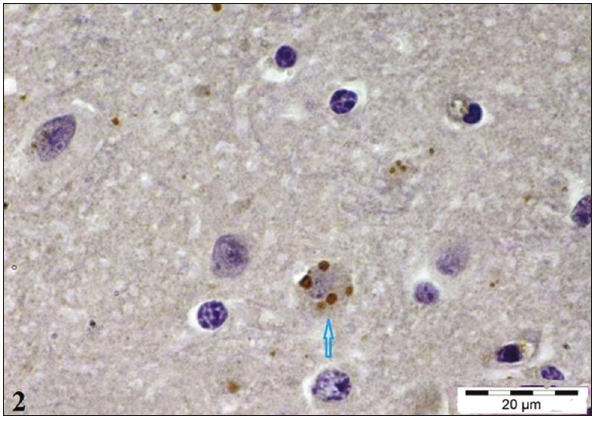
Figure-2: Section of the cerebellum of rabid cattle showing brown colored Negri bodies in the purkinje cells (×100).